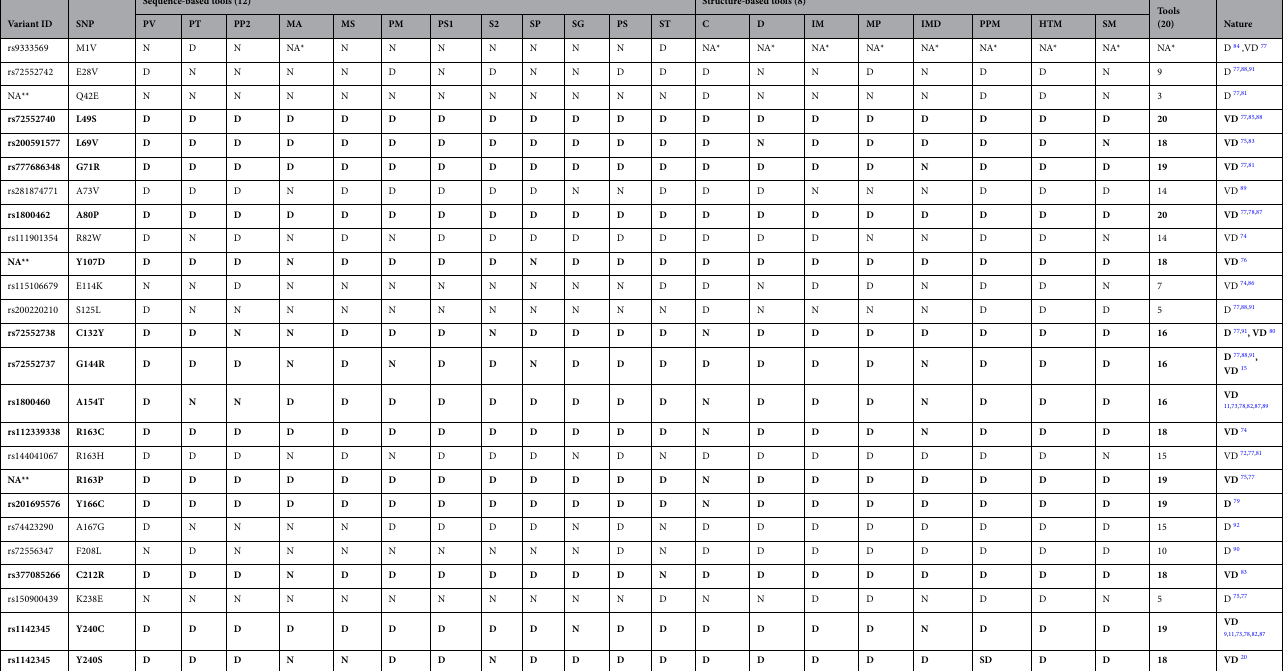
Table 3. Screening of pre-identified SNPs to validate the screening process (SNPs that would get selected as per the screening process utilised in this study are highlighted in bold. PV = PROVEAN, PT = PANTHER, PP2 = PolyPhen-2, MA = Mutation Assessor, MS = Meta-SNP, PM = PMut, PS1 = PredictSNP1, S2 = SNAP 2, SP = SuSPect, SG = SNPs&GO, PS = PhD-SNP, ST = SIFT, C = CUPSAT, D = DUET, IM = I-Mutant, MP = MUpro, structural analysis tools could not be used for this SNP. Mutation Assessor also did not yield any result for this SNP). **NA = Not Available (This pre-identified SNP is not annotated in dbSNP).